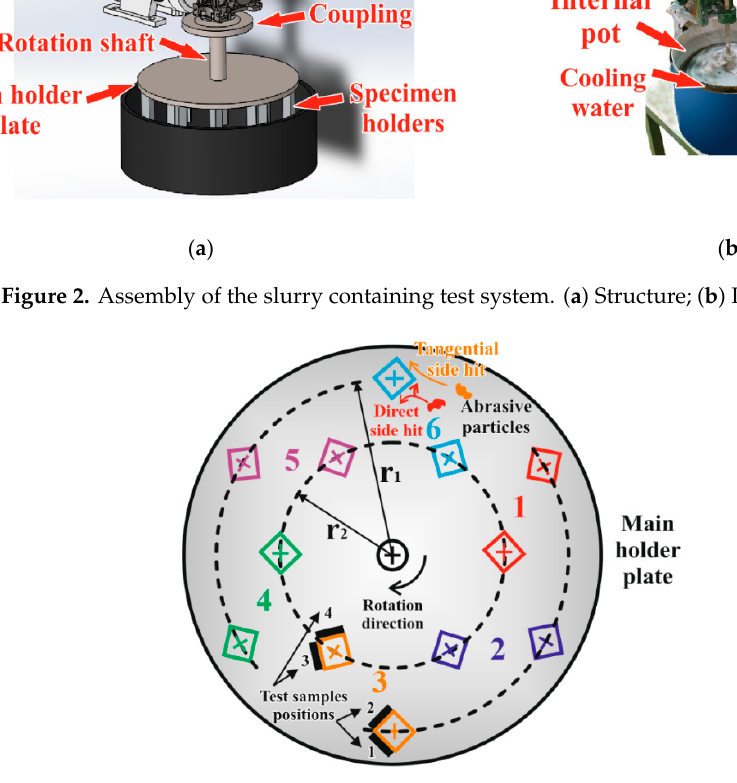
Figure 3. Layout of the 12 holder columns on the main holder plate. Tangential and direct collision, as well as the numbered polymer sample positions (1–4), are indicated.